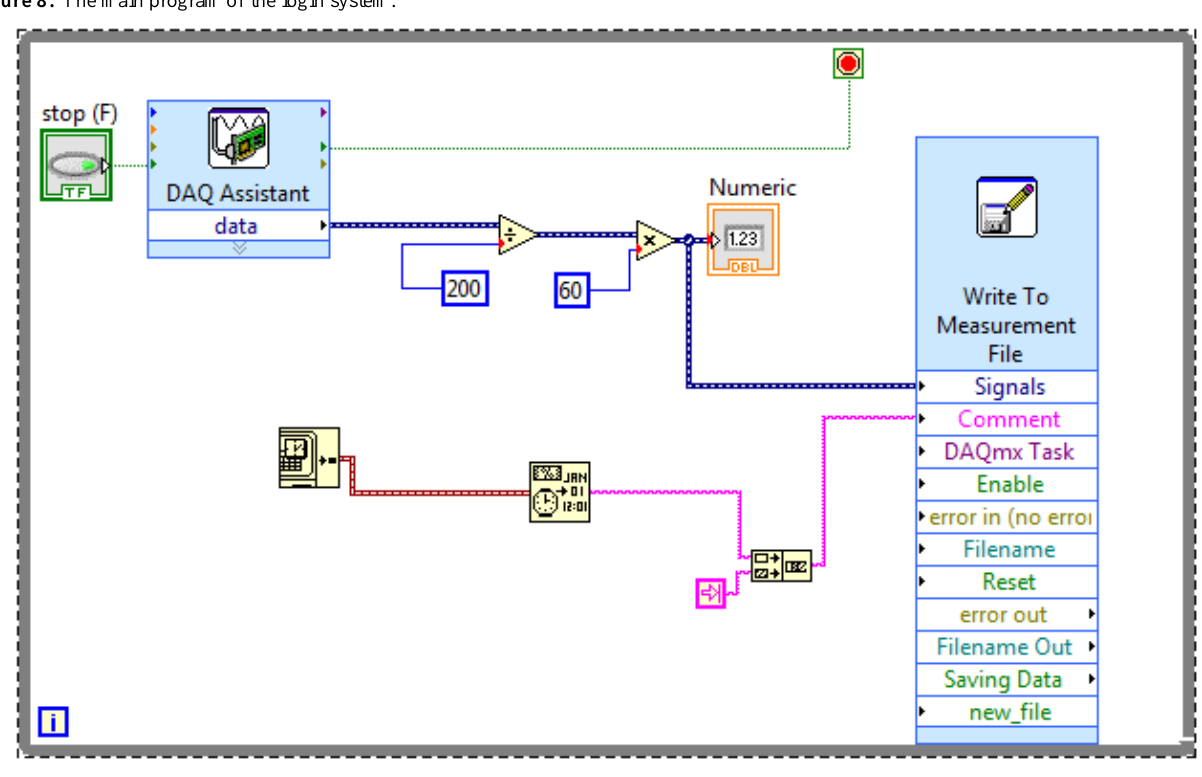
Figure 8. The main program of the login system.